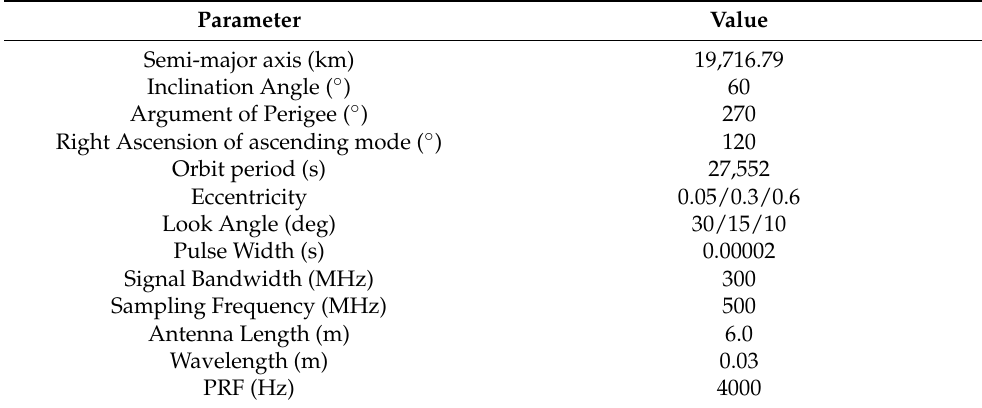
Table 1. Simulation